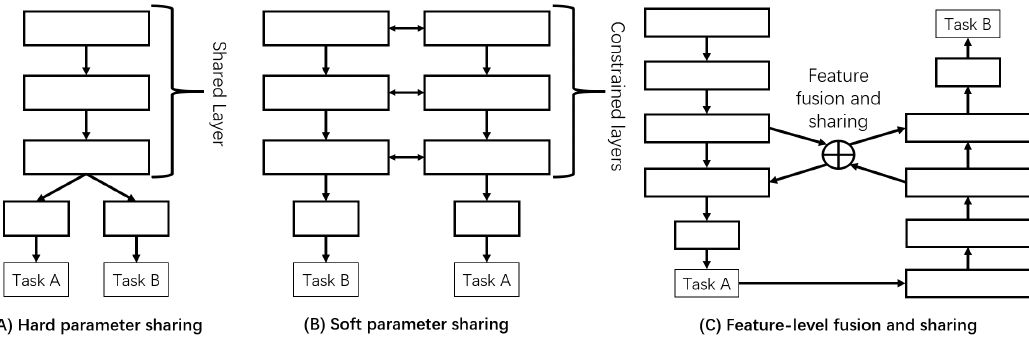
Figure 1. Three multi-task learning methods. ( A , B ) Two widely used multi-task learning methods. ( C ) The method proposed in this paper, which is a novel multi-task learning method with feature-level fusion and